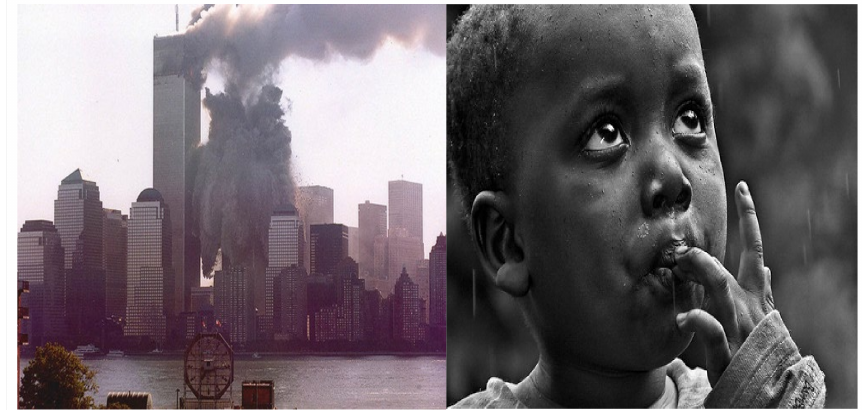
Figure 7. Example of negative sentiment images from the